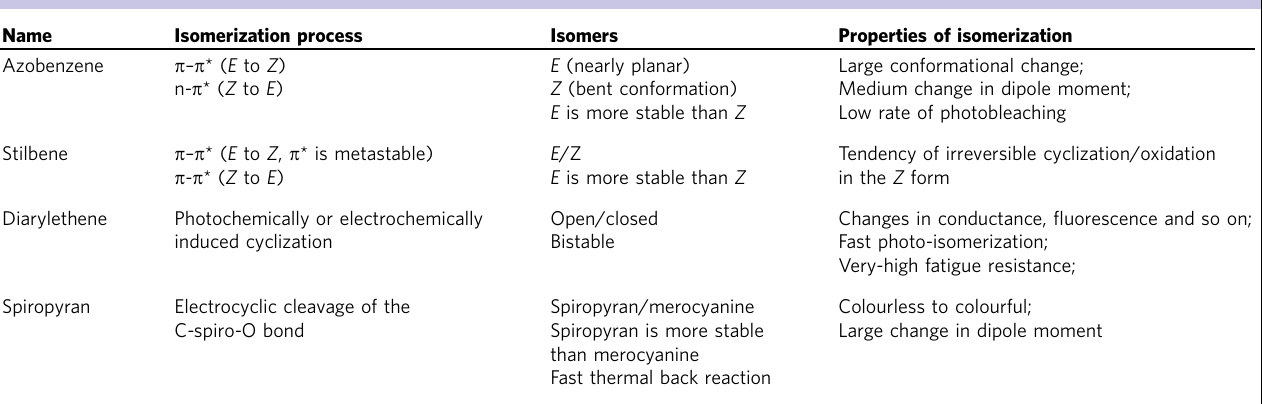
Figure 1 | Chemical structures of the most widely used photochromic molecules. Azobenzenes, stilbenes and spiropyrans can be reverted either photochemically or thermally, while diarylethenes can be switched between open and closed form photochemically or electrochemically. Table 1 | Basic properties of the most widely used photochromic